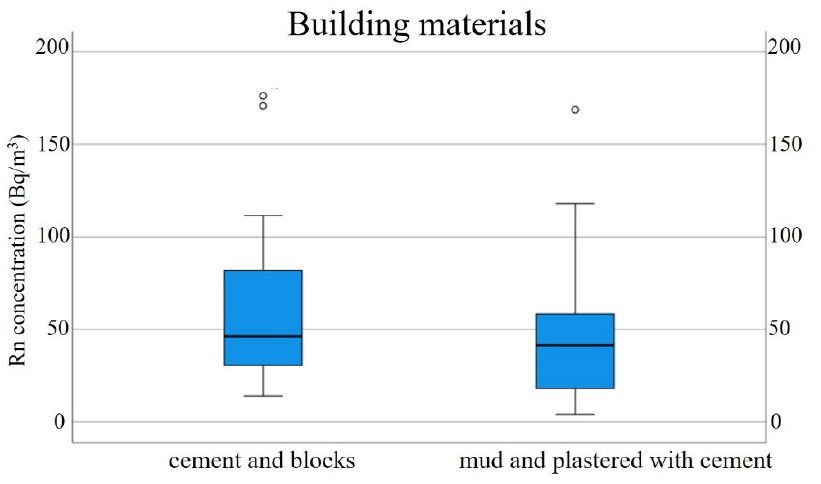
Figure 5. Relationship between radon concentrations and building materials. The graph reports the median and 25th and 75th percentiles; the outlier values are represented by circles.